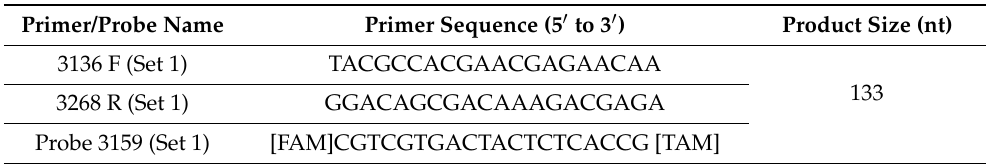
Table 1. Primers and probes designed for the specific detection of the Penaeus vannamei solinvivirus (PvSV) by real-time